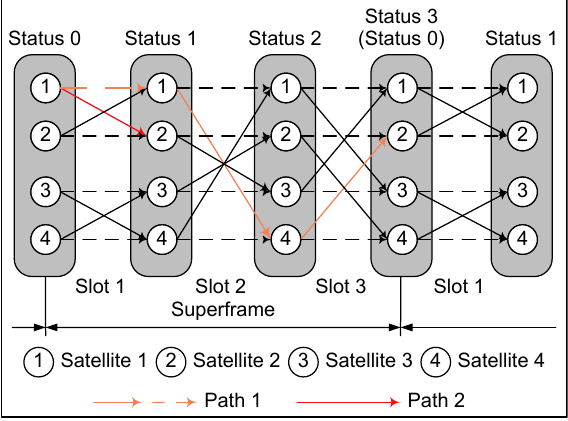
Fig. 2 Dynamic network topology. Fig. 3 Data transmission paths of the satellite